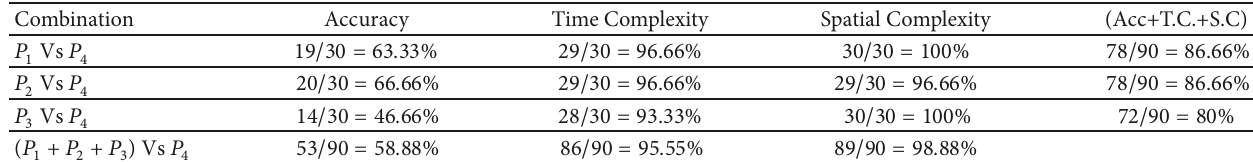
Table 6: Statistically significant differences in each dimension for all HPO across all 𝐷 𝑖 of GB for each comparison between 𝑃 𝑗 (𝐷 𝑖 ) and 𝑃 4 (𝐷 𝑖 ) and the total (%).